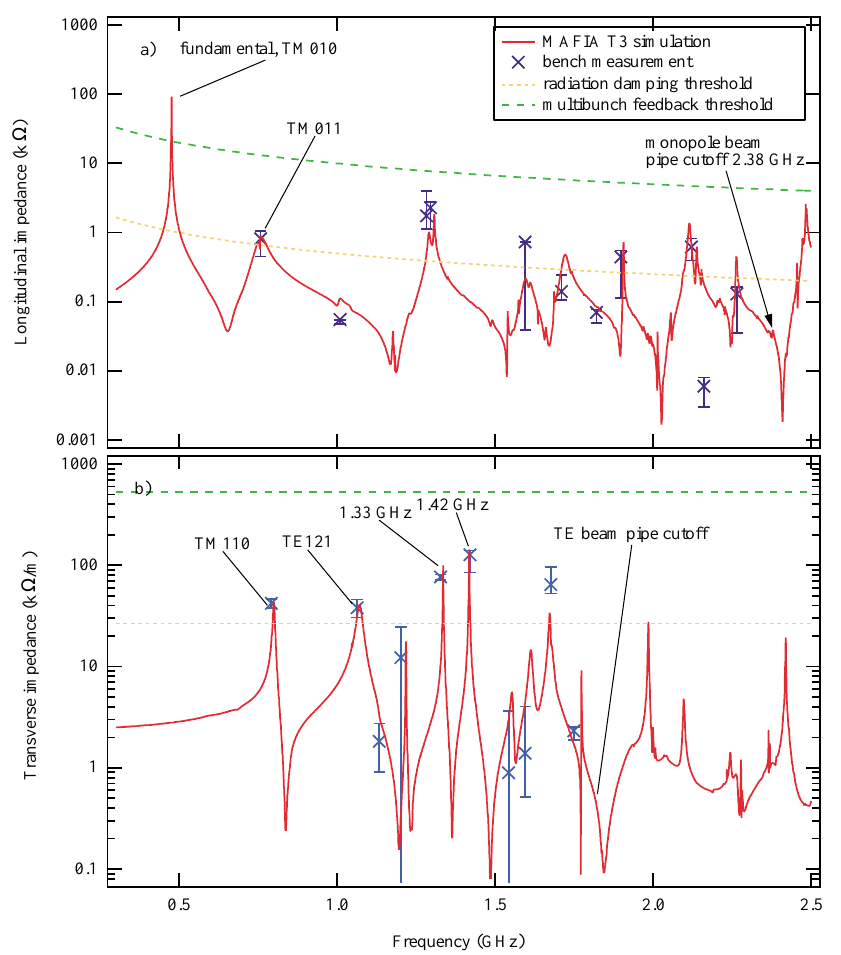
FIG. 4. (Color) Impedance spectra calculated from Fourier transforming time domain wakes and estimates of mode impedances mea- sured in a cold-test model of the PEP-II cavity. The effective impedances for damping from synchrotron radiation and the multibunch feedback system at the nominal LER parameters are also shown. (a) Longitudinal impedance and (b) transverse